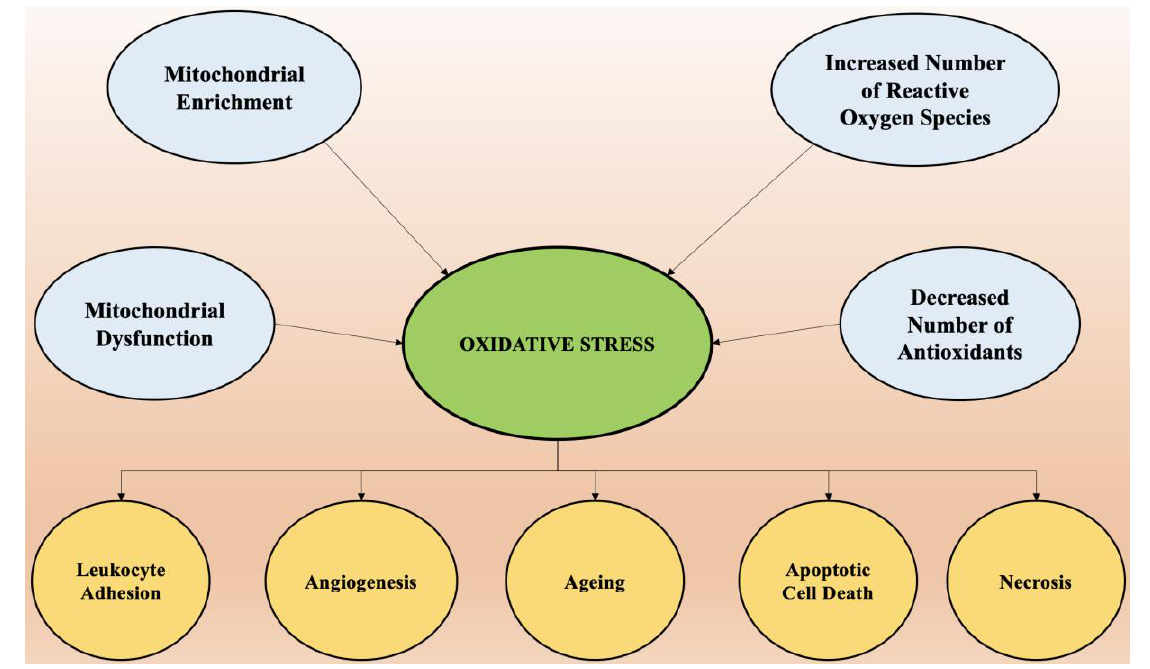
Figure 3. The factors that cause oxidative stress and the physiological changes that come as a result of increased reactive oxygen species.